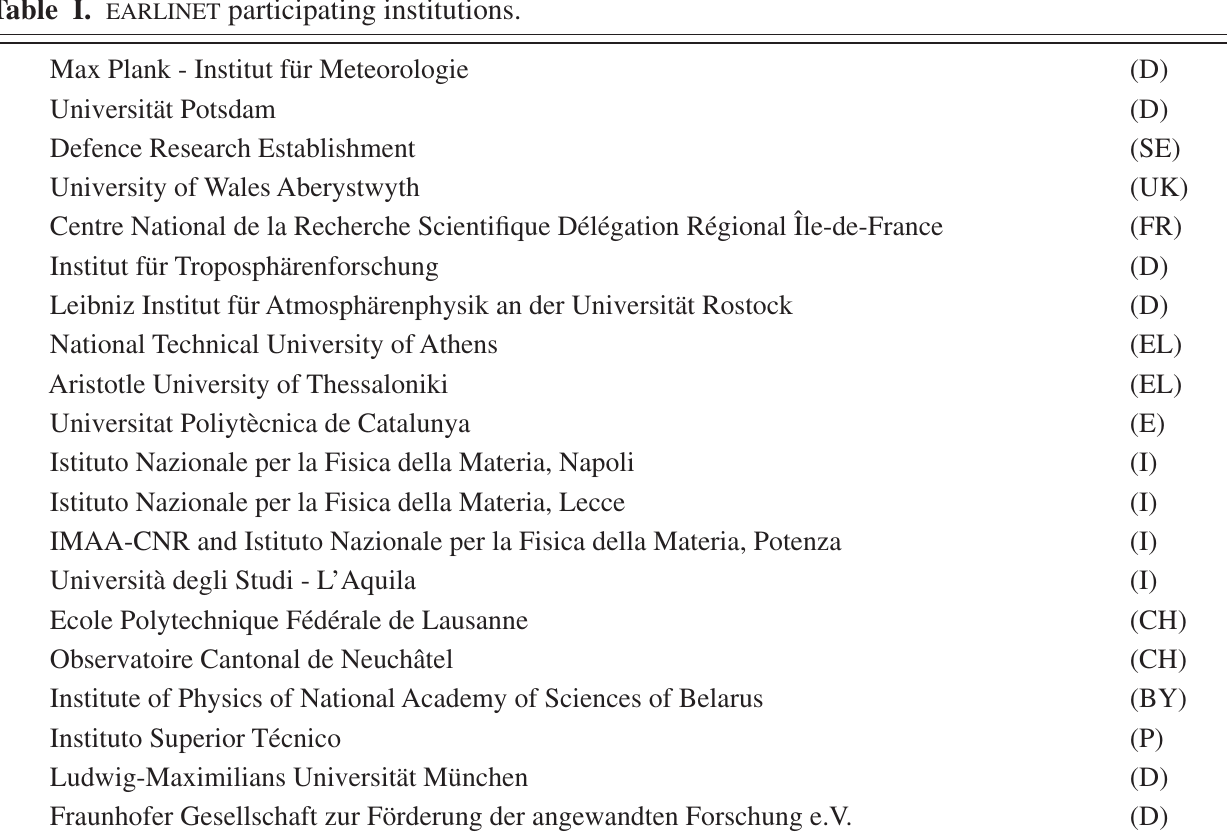
Table I. EARLINET participating